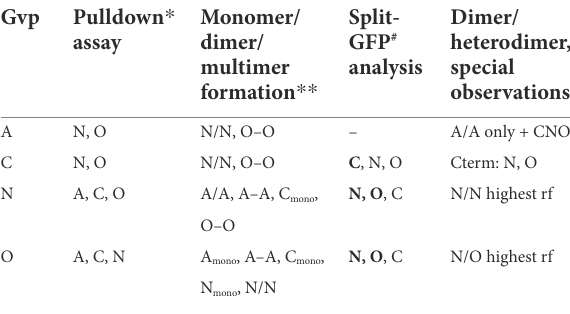
TABLE 1 Interactions of Gvp